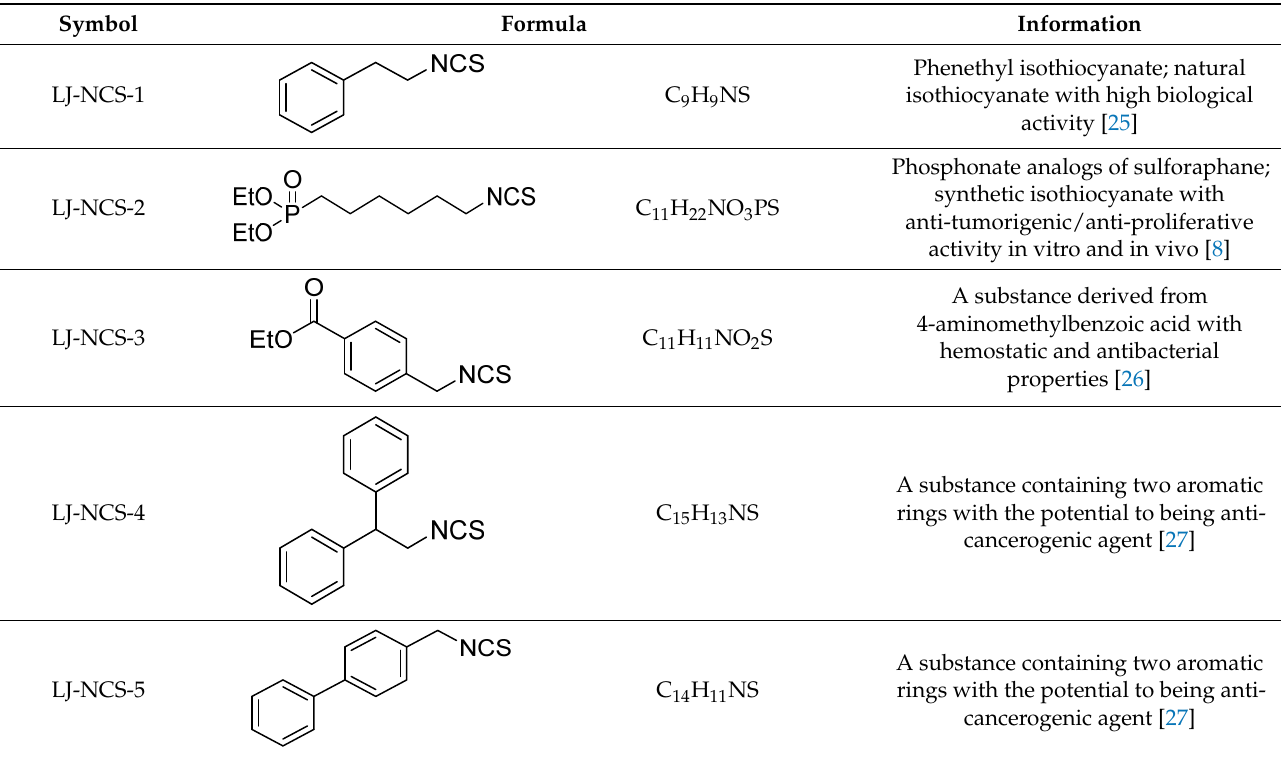
Table 1. Isothiocyanates tested in the experiments.